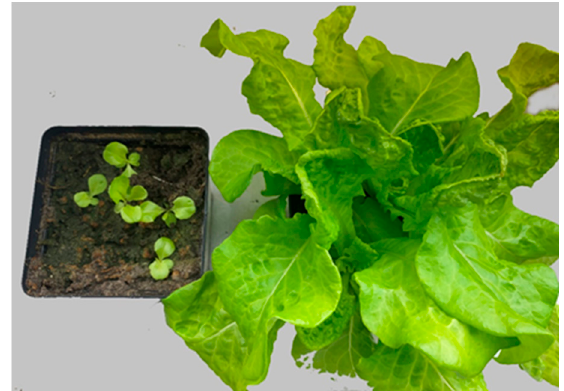
Figure 2. Lettuce growth in 6th week of the EX 2 experiment on control soil without MIX (CS) (on the left) on soil with MIX (SCBC) (on the right).